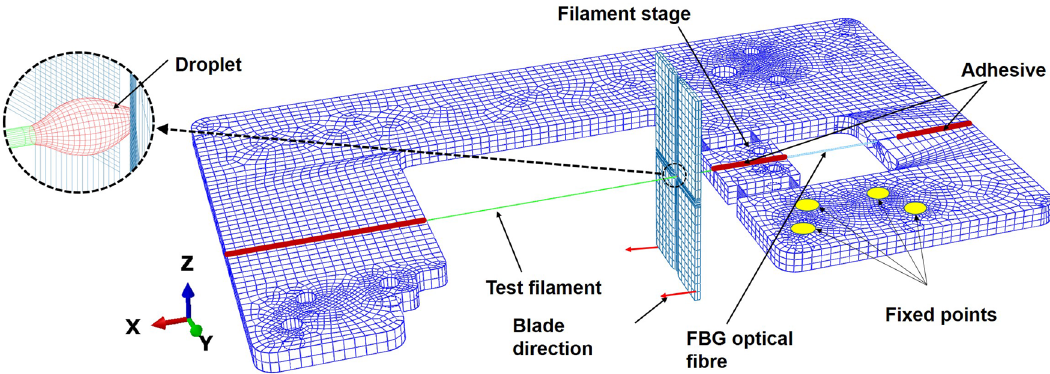
Figure 9. ( a ) FE model of the MB test system. An element type of 8-node linear brick (C3D8R) is used for all parts of the FE model. [This figure is generated using Abaqus Standard/Explicit software, version 2017, https:// www. 3ds. com/ produ cts- servi ces/ simul ia/ produ cts/ abaqus/].